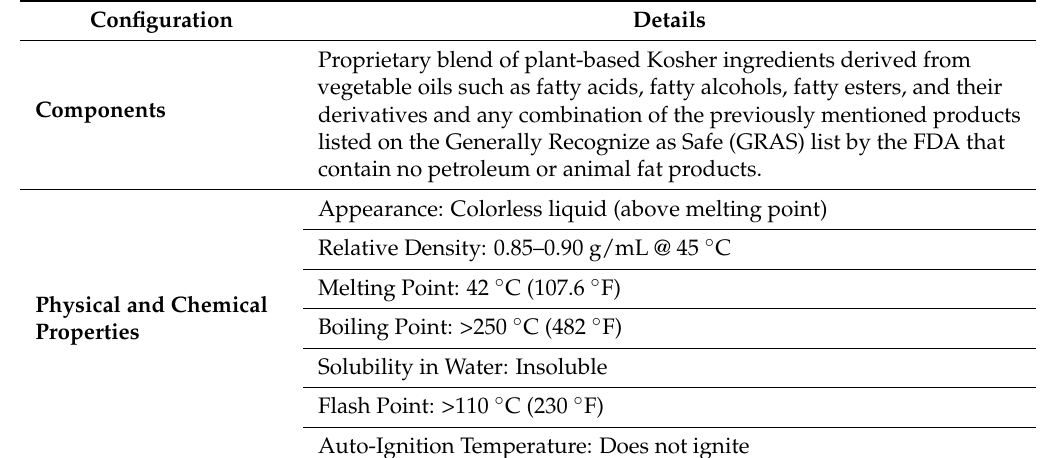
Table 3. The physical properties of the PCM applied to the floor heating